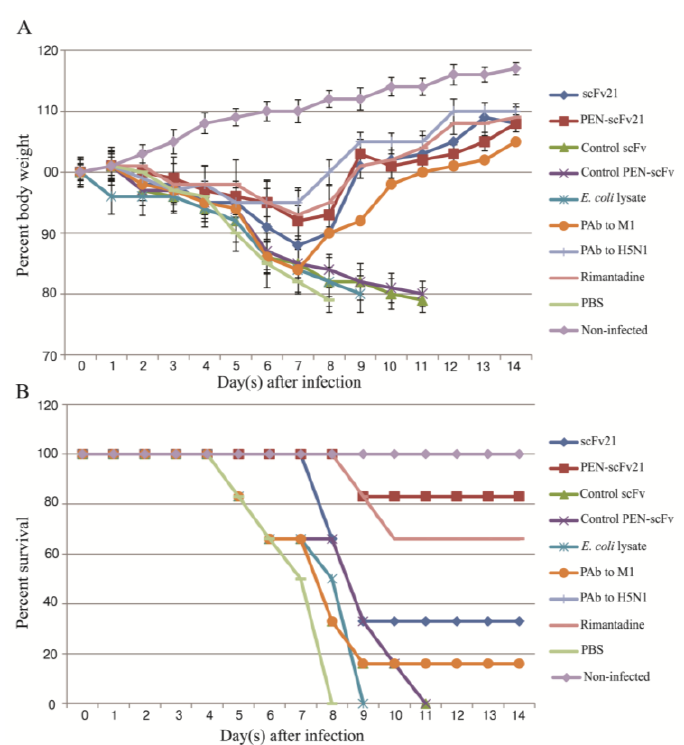
Figure 4. Percent body weight (mean and SD) and survival of infected mice that received different treatments, i.e. , scFv21, PEN-scFv21, control scFv, control PEN-scFv, E. coli lysate, PAb to M1, PAb to H5N1, rimantadine and PBS in comparison with the non-infected mice. ( A ) Percent body weight; ( B ) Percent